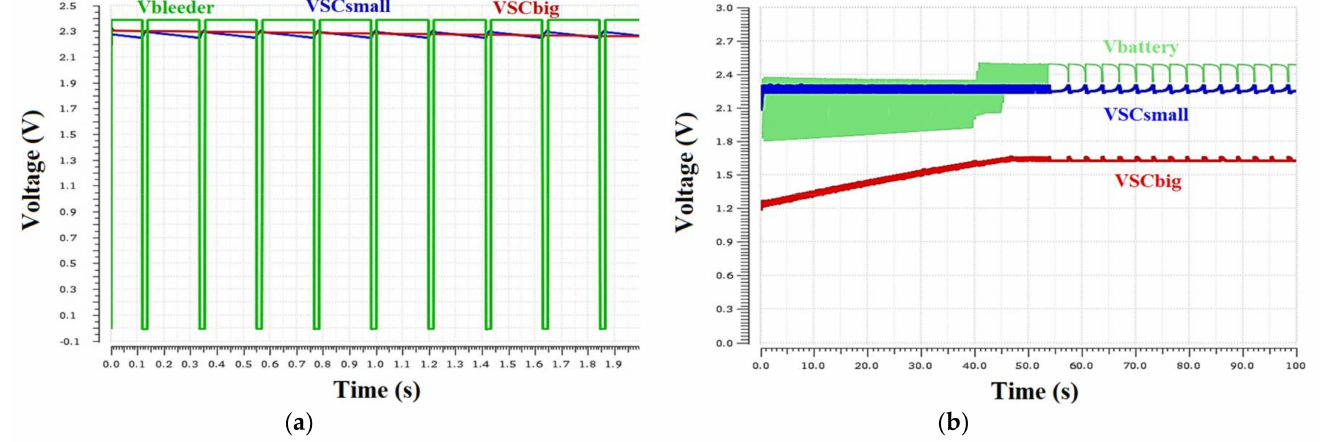
Figure 7. ( a ) Bleeder mode activation. The bleeder mode is activated only when both supercapacitors are fully charged. ( b ) Battery energy support. Initially, the battery charges both supercapacitors. SCbig charging stops when its voltage reaches the lower voltage threshold (1.6 V). SCsmall is charged to its high threshold (2.3